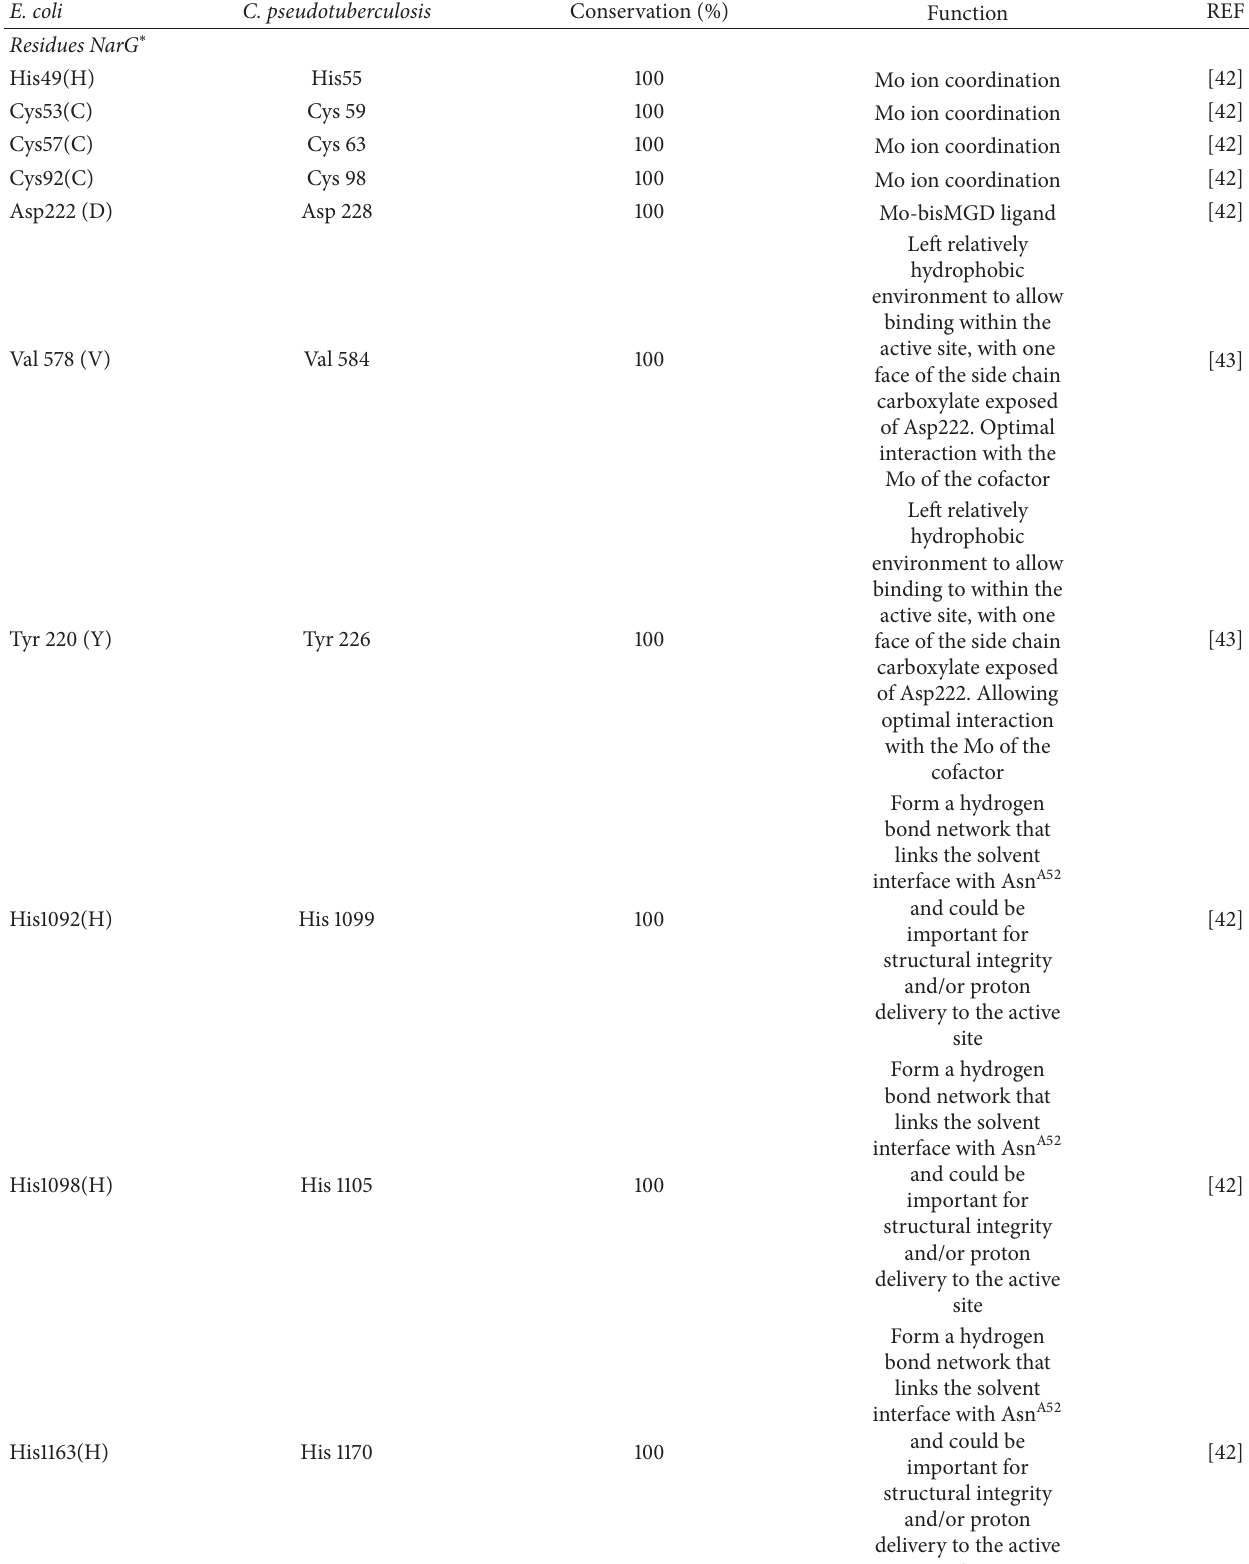
Table 3: Residues analyzed regarding the conservation between the narGHI protein sequences of E. coli and C. pseudotuberculosis . E.